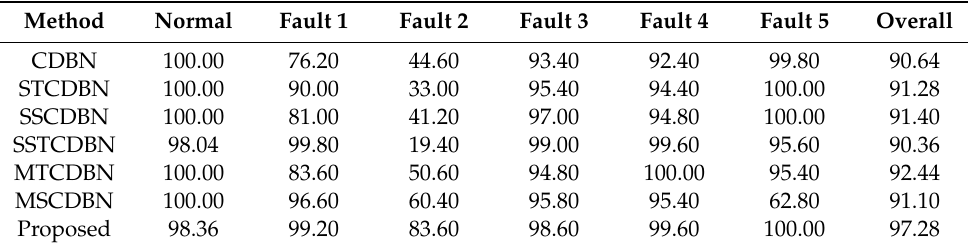
Table 7. Recognition accuracy of each health condition (%).